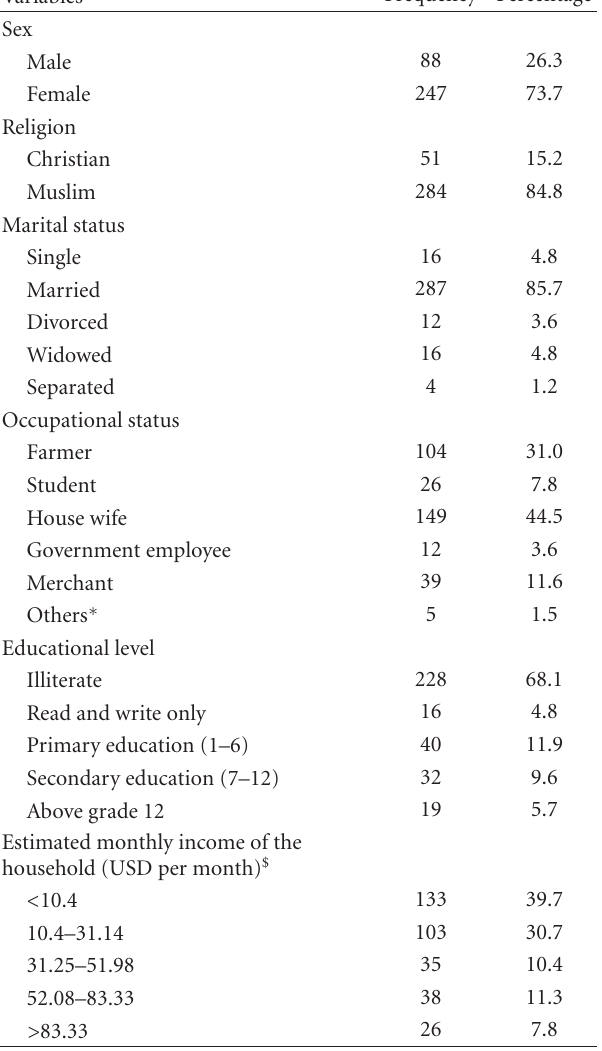
Table 1: Sociodemographic characteristics of respondents in Gursum district, Ethiopia, 2008.